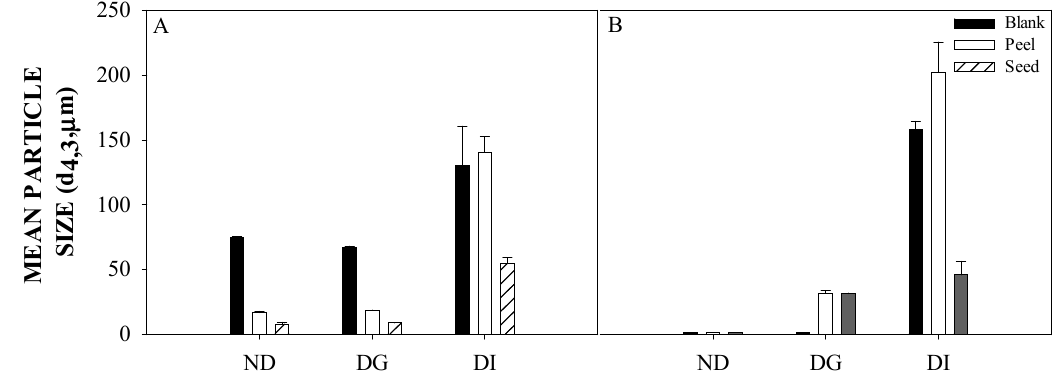
Figure 2. Changes in the particle size of oil-in-water (O/W) dispersions and emulsions, stabilized with low methoxyl pectin (LMP), containing avocado peel and seed extracts during simulated gastric and intestinal digestion conditions. ( A ) = O/W dispersions; ( B ) = Emulsions containing LMP. ND = Non digested; DG = Gastric digestion; DI = Intestinal digestion